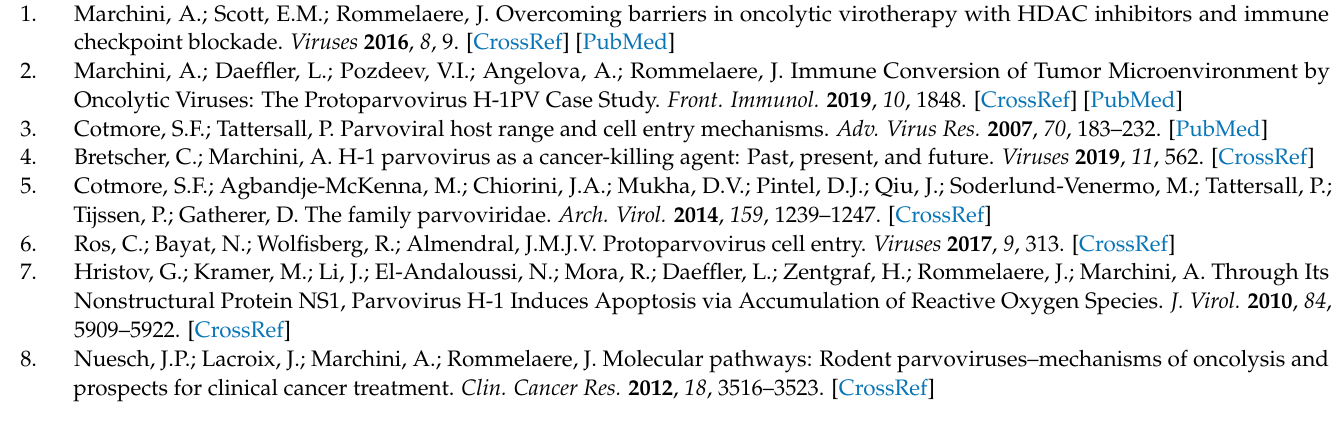
Figure S6: NCI60 database retrieved LGALS1 and LAMC1 expression levels showed anti-correlation with EC50 values and a slight increase in the ability to predict susceptibility to H-1PV induced oncotoxicity. Figure S7: CCLE database that retrieved LGALS1 and LAMC1 expression levels showed anti-correlation with EC50 values and showed a slight increase in the ability to predict susceptibility to H-1PV induced